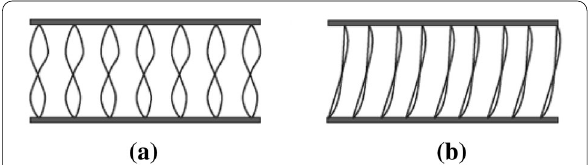
Fig. 1 Cross-section of 3D-fiberglass: a warp view and b weft view (Fan et al.,